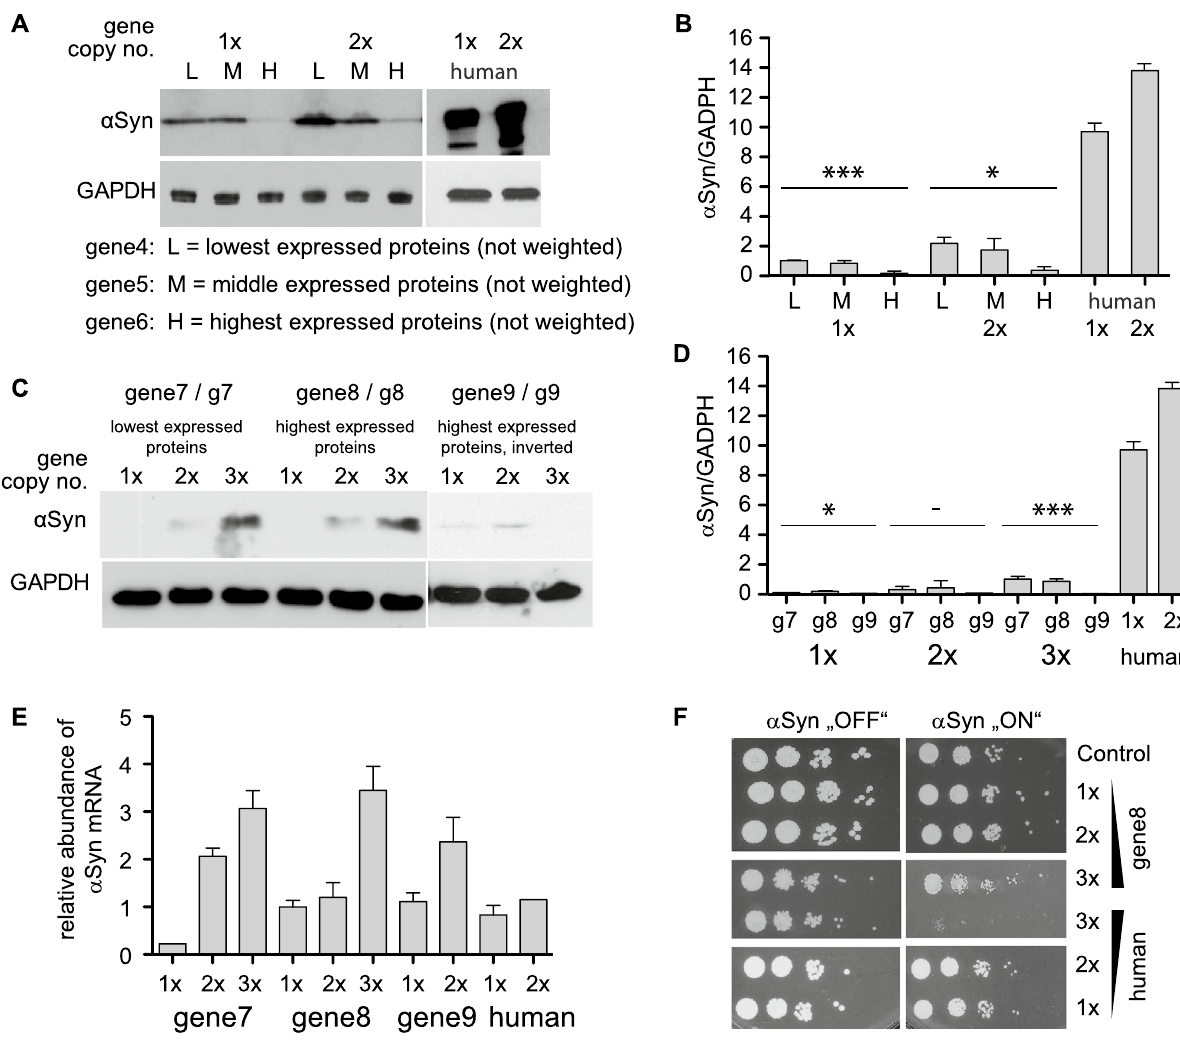
Figure 5. Expression of designed and human α-synuclein. ( A ) Western blot analysis for determination of the protein level of αSyn. Protein expression was induced for 6 h, crude protein extracts were prepared and the protein concentrations were determined with a Bradford assay. 160 μg crude protein extract from samples gene4 (L), gene5 (M) and gene6 (H), and 40 μg from samples “human” were used for Western blotting. The membrane was probed with anti αSyn antibody. GAPDH antibody was used as a loading control. The full-sized blots are available in Supplementary Fig. S3. ( B ) Quantification of the protein levels of αSyn. Densitometric analysis of the immunodetection of αSyn, relative to GAPDH loading control. The significance of the differences was calculated with a One-way Anova-test (*p = 0.0107; ***p = 0.00014; n = 3). ( C ) Western blot analysis of crude protein extracts from yeast strains, expressing GAL1- driven αSyn from one, two and three copies. Protein expression was induced for 6 h, crude protein extracts were prepared and the protein concentrations were determined with a Bradford assay. 160 μg crude protein extract from samples gene7, gene8 and gene9, and 40 μg from samples “human” were used for Western blotting. The membrane was probed with anti-αSyn antibody. GAPDH antibody was used as a loading control. The full-sized blots are available in Supplementary Fig. S4. ( D ) Quantification of the steady-state protein level of αSyn. Densitometric analysis of the immunodetection of αSyn, relative to GAPDH loading control. The significance of the differences was calculated with a One-way Anova-test (*p = 0.038; -p = 0.41; ***p = 0.00034; n = 3). ( E ) Quantification of SNCA gene expression. RNA was prepared from yeast strains after 6 h induction of αSyn expression. Relative αSyn mRNA levels were determined by qRT-PCR and normalized against H2A. Expression values represent the mean of three replicates ± standard error. ( F ) Growth analysis of yeast cells expressing αSyn from one, two and three gene copies, driven by the inducible GAL1- promoter on non-inducing (‘OFF’: glucose) and inducing (‘ON’: galactose) SC-URA medium after 3 days. Yeast cells expressing GFP from the same promoter were used as a